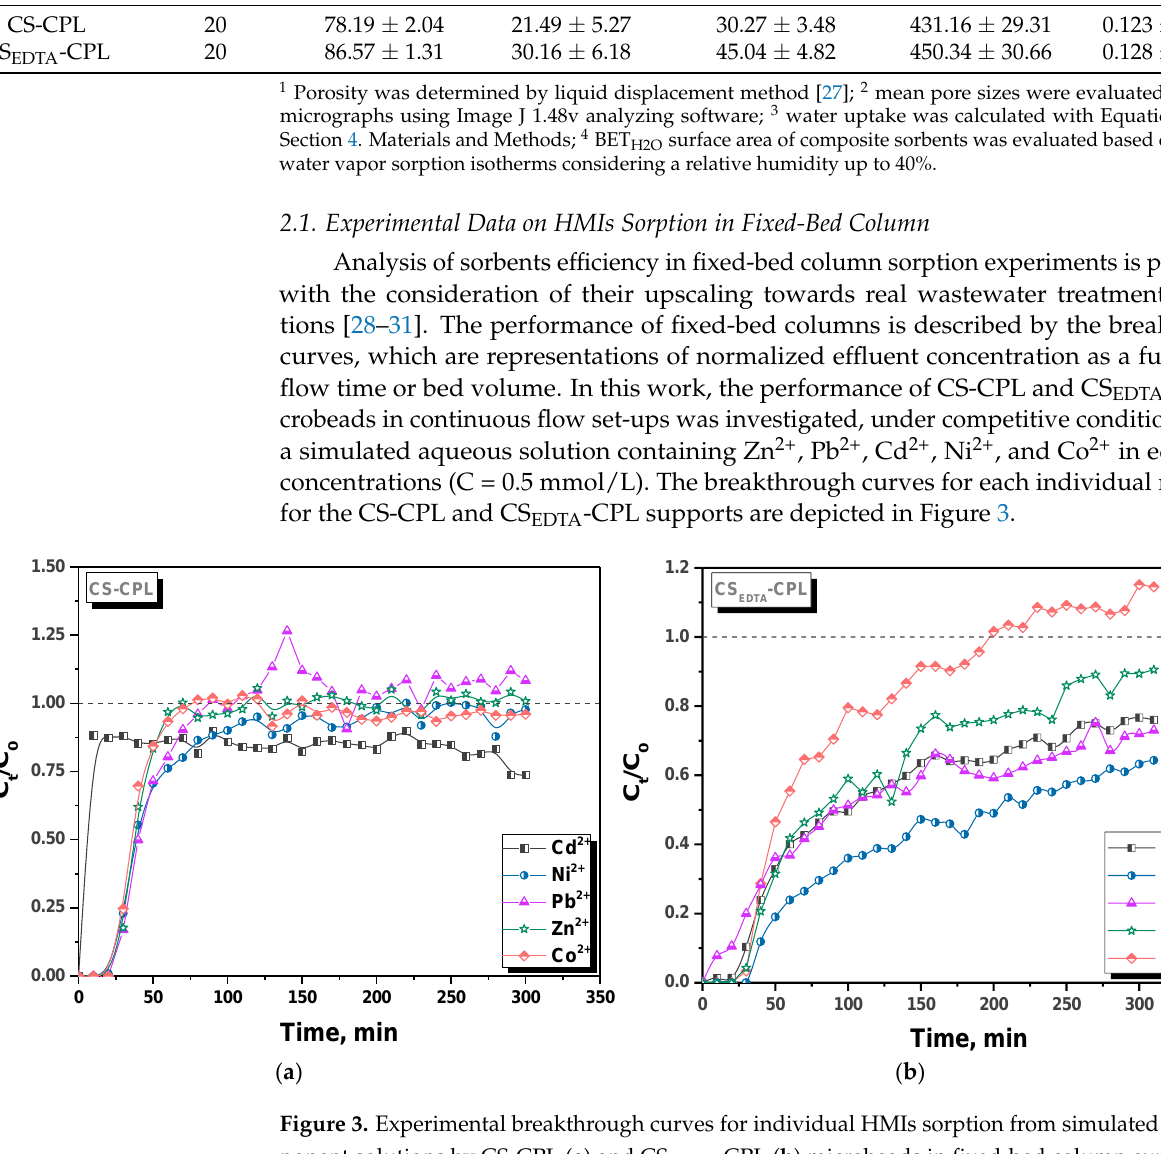
Table 2. Some features of the CS-CPL and CS EDTA -CPL composite sorbents. CPL, Sample Code wt.%